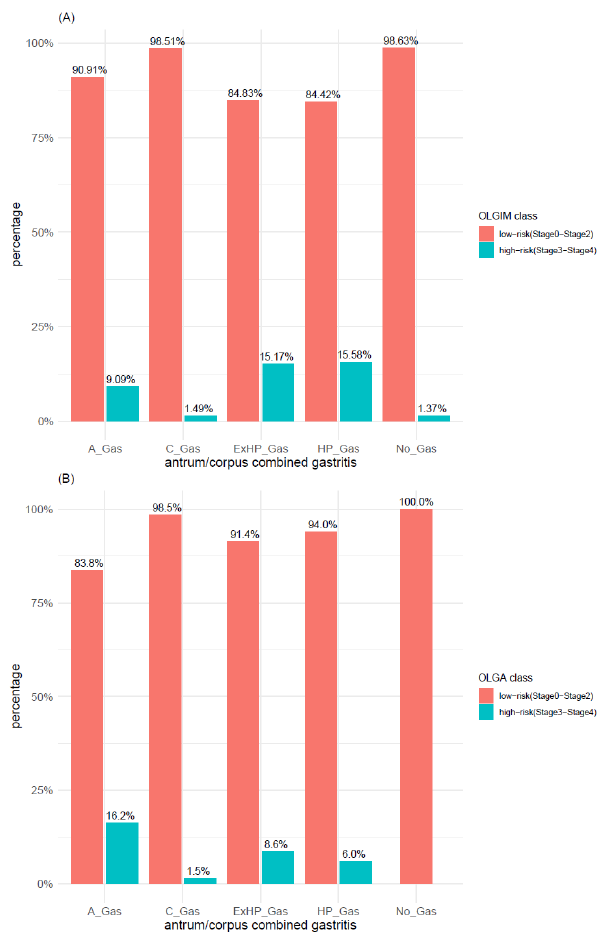
Figure 8. Distribution of ( A ) intestinal metaplasia and ( B ) atrophy within the main gastritis types according to low- and high-risk of OLGA and OLGIM classes. A_Gas: autoimmune gastritis; C_Gas: chemical reactive gastritis; ExHP_Gas: Ex- H. pylori Gastritis; HP_Gas: H. pylori Gastritis; No_Gas: no gastritis; OLGA: operative link on gastritis assessment; OLGIM: operative link on gastric intestinal metaplasia assessment.